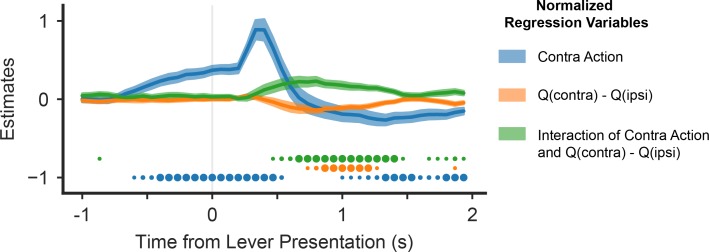
Mixed effect model regression on GCaMP6f traces of VTA/SN::DMS terminals (n = 12 recording sites) using the difference in Q values for contralateral and ipsilateral choices.Same analysis as Figure 3c, except explanatory variables include the action of the mice (blue), the difference in Q values for contralateral and ipsilateral choices (orange), their interaction (green), and an intercept. Colored fringes represent ±1 standard error from estimates (n = 12 recording sites). Dots at bottom mark timepoints where the corresponding effect is significantly different from zero at p<0.05 (small dot), p<0.01 (medium dot), p<0.001(large dot). P values were corrected with Benjamini Hochberg procedure.